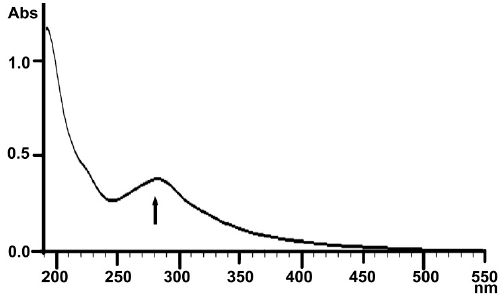
Figure 3. UV spectrum of LBP.